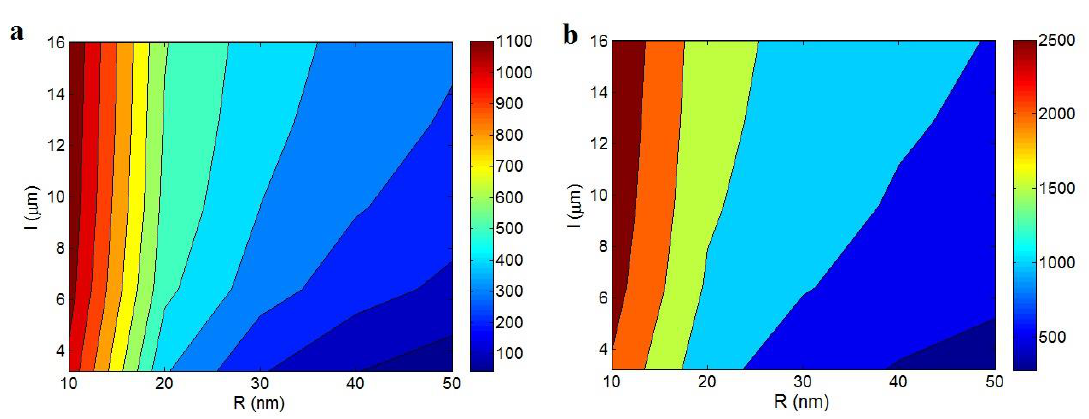
Figure 4. The roles of “R” and “l” parameters in the electrical conductivity of PCNT based on ( a ) conventional equation (Equation (9) at b = 2 and ( b ) developed model (Equation (12)).